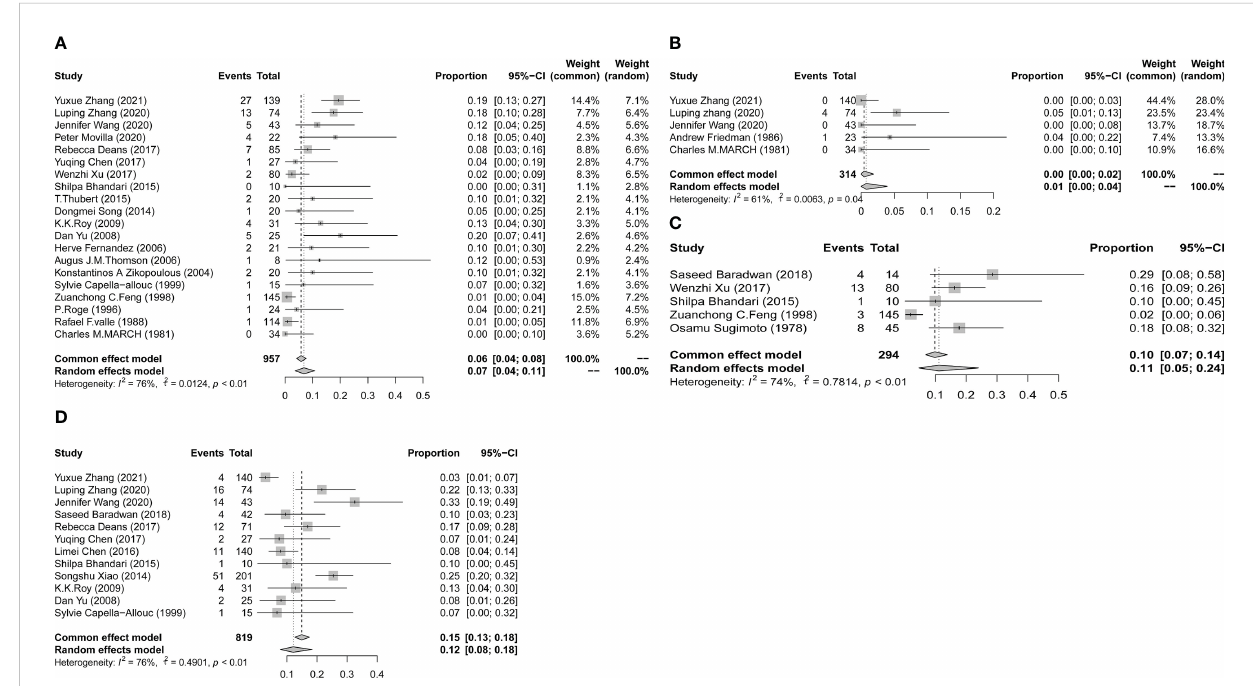
FIGURE 4 Forest plot diagrams of placenta accreta (A) , placenta increta (B) , retained placenta (C) , and postpartum hemorrhage (D) . (total number: number having live births).